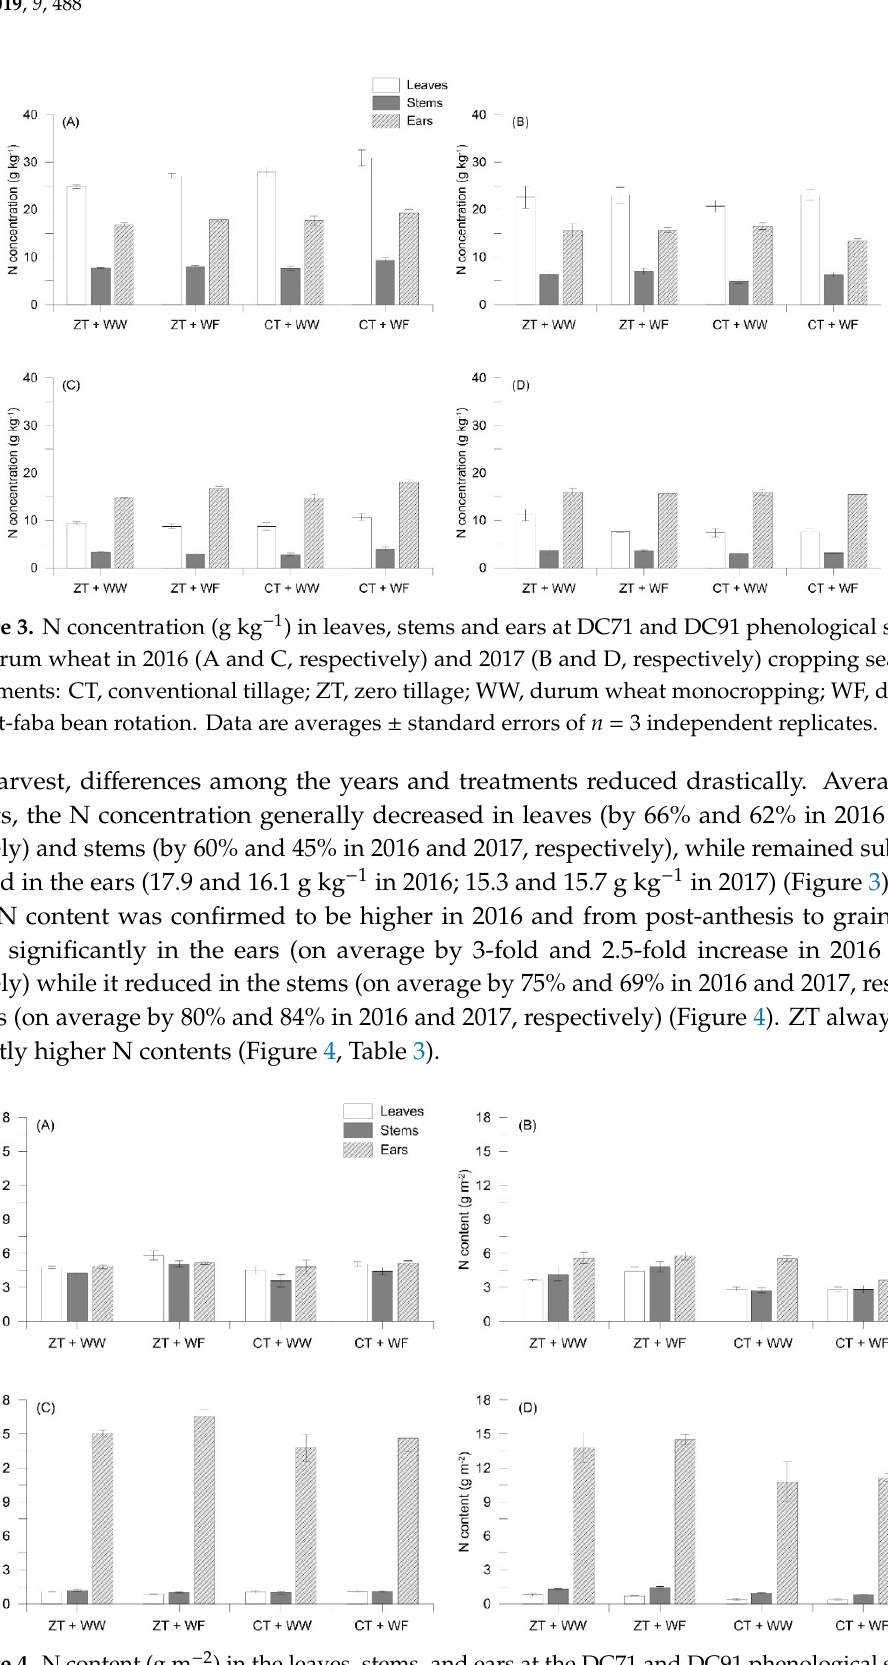
Figure 4. N content (g m − 2 ) in the leaves, stems, and ears at the DC71 and DC91 phenological stages of durum wheat in 2016 (A and C, respectively) and 2017 (B and D, respectively) cropping seasons. Treatments: CT, conventional tillage; ZT, zero tillage; WW, durum wheat monocropping; WF, durum wheat-faba bean rotation. Data are averages ± standard errors of n = 3 independent replicates. The amount of N remobilized into kernels during grain filling were very similar between the years (77.0% and 76.0% in 2016 and 2017, respectively, averaged over ST and CS) (Table 2). The effect of ST was related to the crop growing season (see the significance of the interaction “Year × ST” in Table 3). Furthermore, although not significant, WF induced higher NRemE (79.5% vs. 74.6% in 2016 and 77.7% vs. 74.7% in 2017) (Table 2). The GPC values were similar between the two years (Figure 5), while the effect of both ST and CS was significant ( p < 0.05, Table 3). ZT induced higher values with respect to CT (12.07% vs. 10.32%) and WF than WW (11.52% vs. 10.87%); the highest values was obtained by the combination of ZT + WF (12.5%, averaging 2016 and 2017).